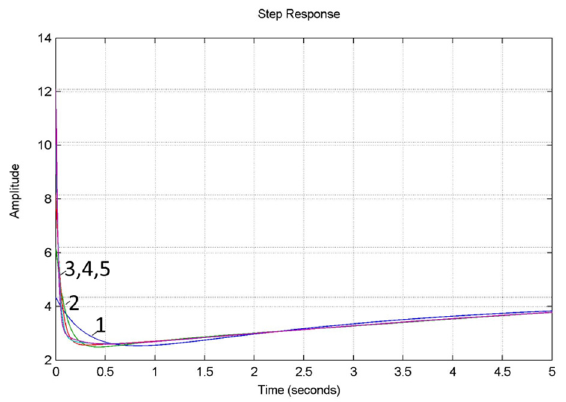
Figure 6. Transition processes of the PI λ D µ -controllers (26) for n = 1, 2, . . . , 5.